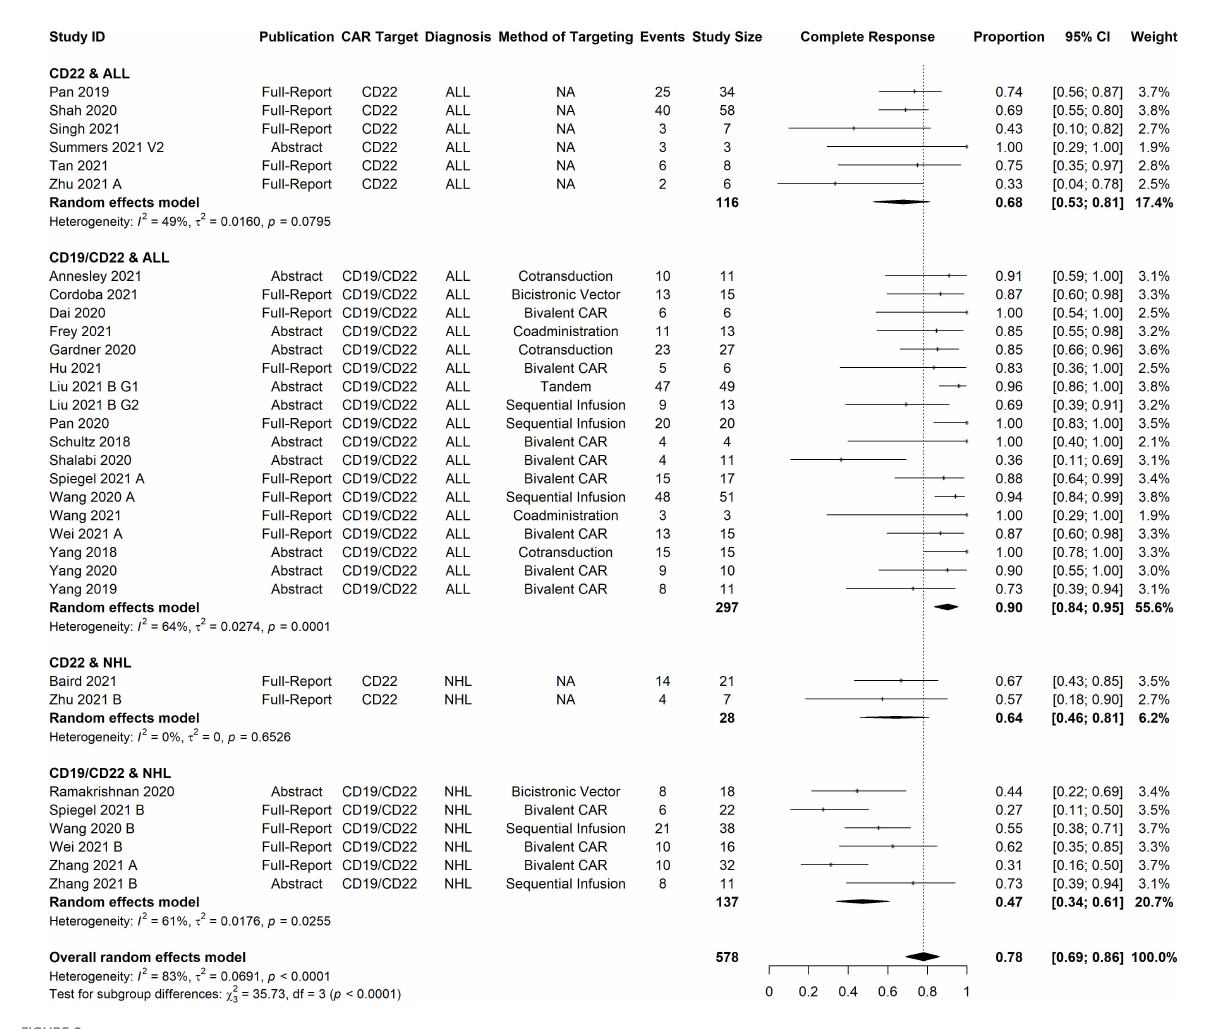
FIGURE 2 Forest plot of best complete response rate organized by malignancy type and antigen target. Pooled estimates, represented by the black diamond, were calculated for each subgroup and overall weighted